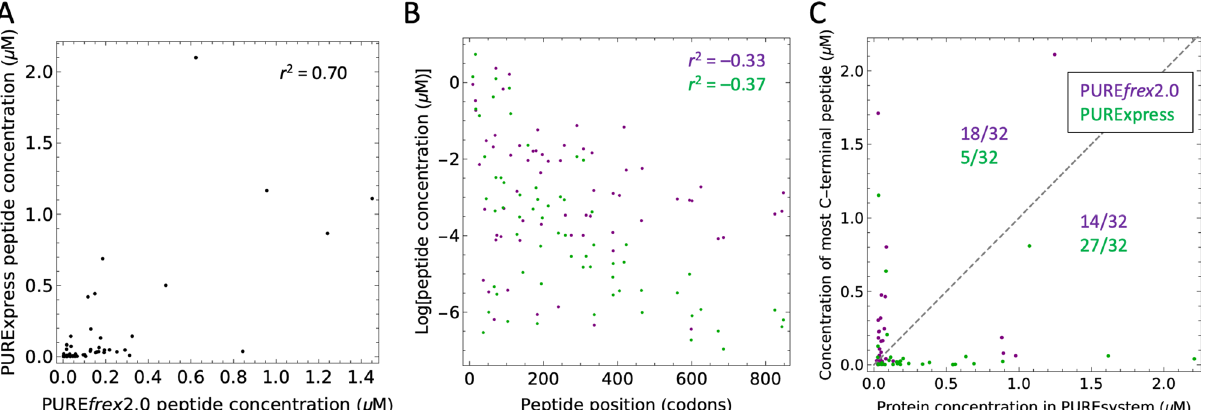
Figure 6. Correlation analyses of absolute peptide concentrations for pTFM1 expression. Correlations of absolute peptide expression levels between PURE frex 2.0 and PURExpress ( A ), with the peptide position within the coding sequence ( B ), and with their initial amounts in the commercial kits ( C ). ( A , B ) Values of r 2 denote Pearson correlation coefficients. ( B , C ) Data points for PURE frex 2.0 and PURExpress are colored in magenta and in green, respectively. ( C ) The most C-terminal peptide for each protein was used for analysis. The appended dashed line depicts the slope equal to 1. PURE frex 2.0 and PURExpress reactions were run in the homemade buffer containing 15 N-labeled amino acids. Concentrations of synthesized proteins were derived from 15 N-to- 14 N peak ratios, while the concentrations of PURE system components were determined in separate experiments using QconCAT as an internal standard. For each PURE system kit, the number of proteins whose concentration falls above ([protein] expressed > [protein] input ) or below ([protein] expressed < [protein] input ) the diagonal is